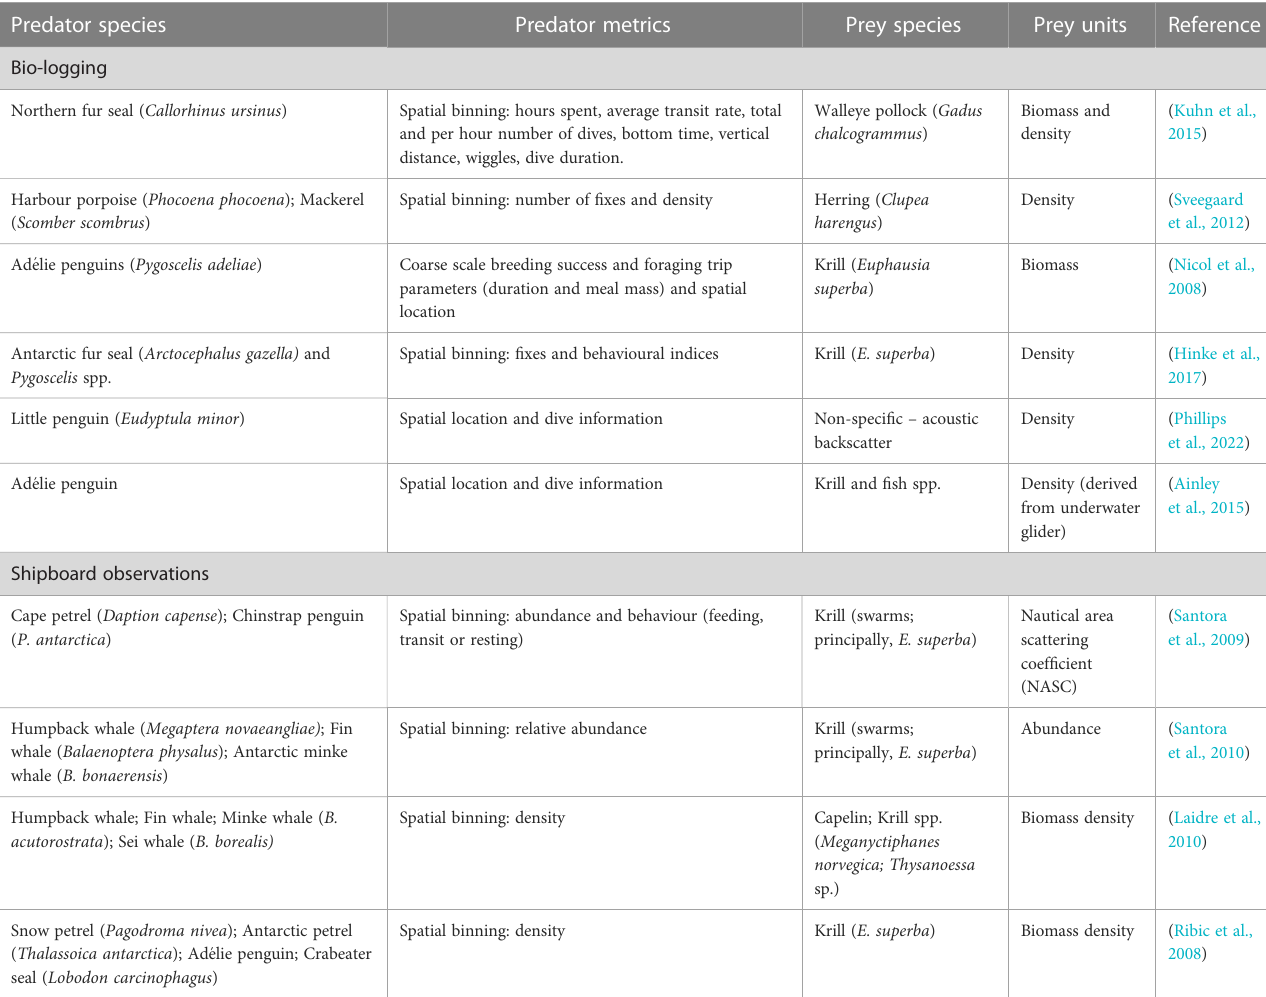
TABLE 1 Examples of studies on predator-prey relationship which couple prey fi eld acoustic surveys with predator locations through biologging or shipboard